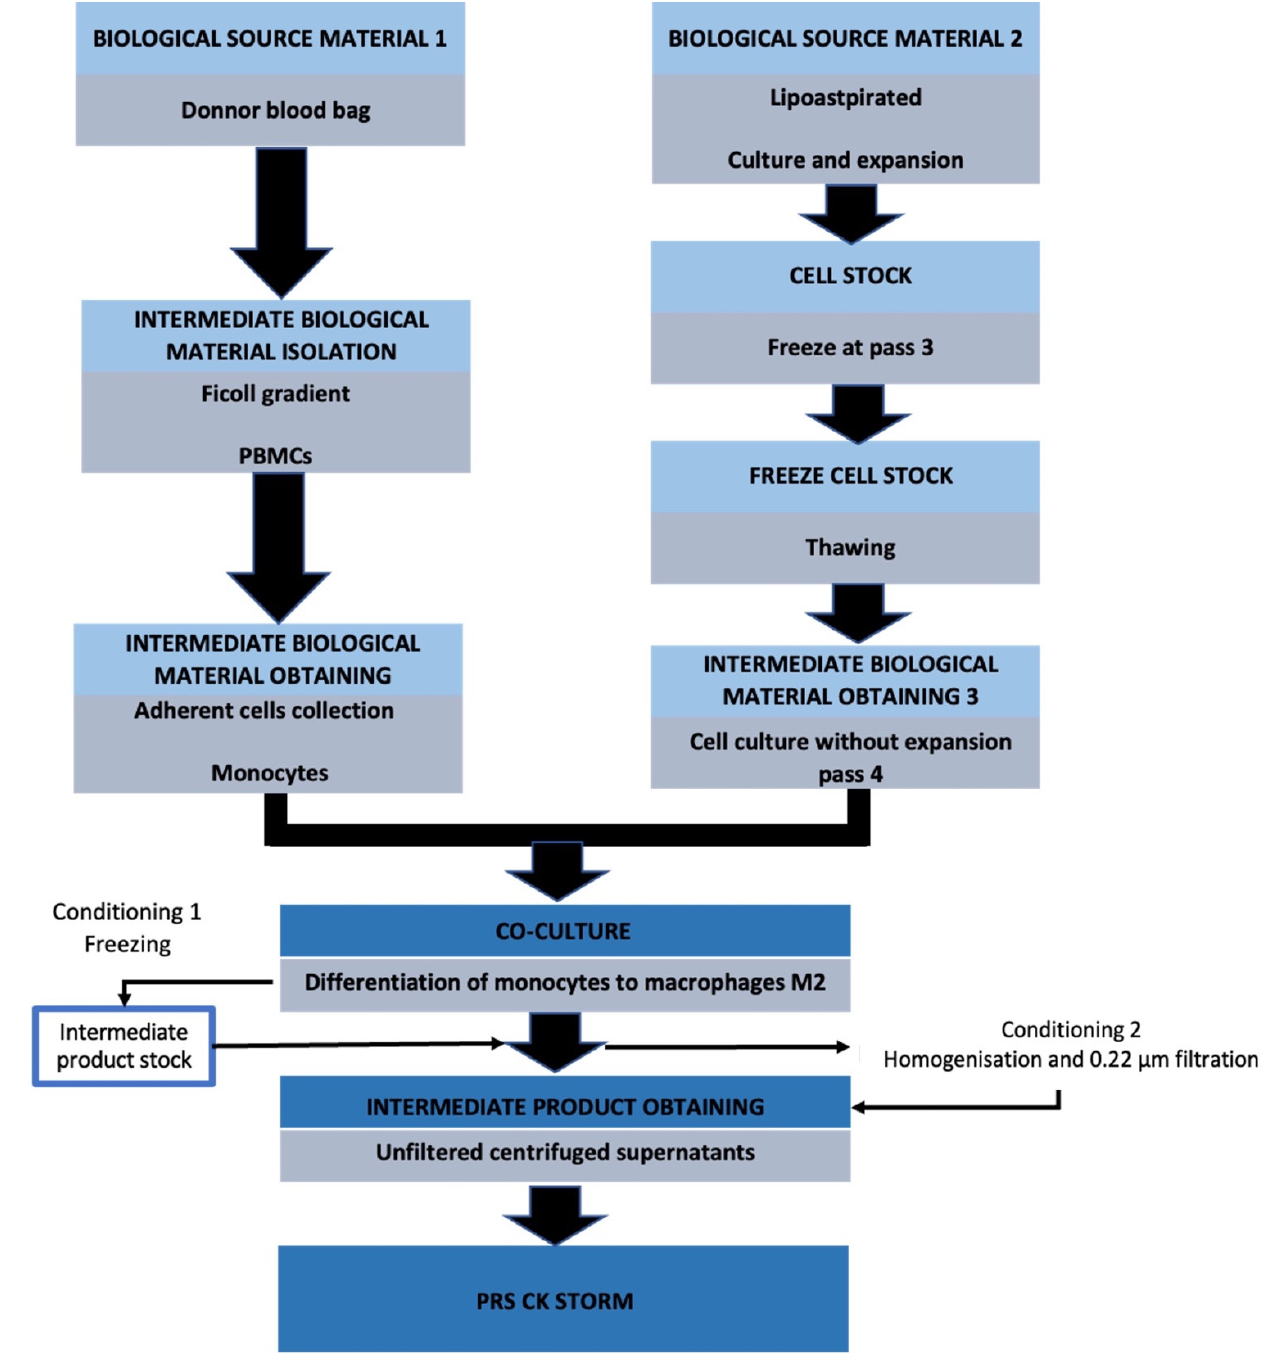
Figure 1. Schematic description of the production process of allogeneic conditioned medium derived from M2-type macrophages and enriched with MSCs [26].